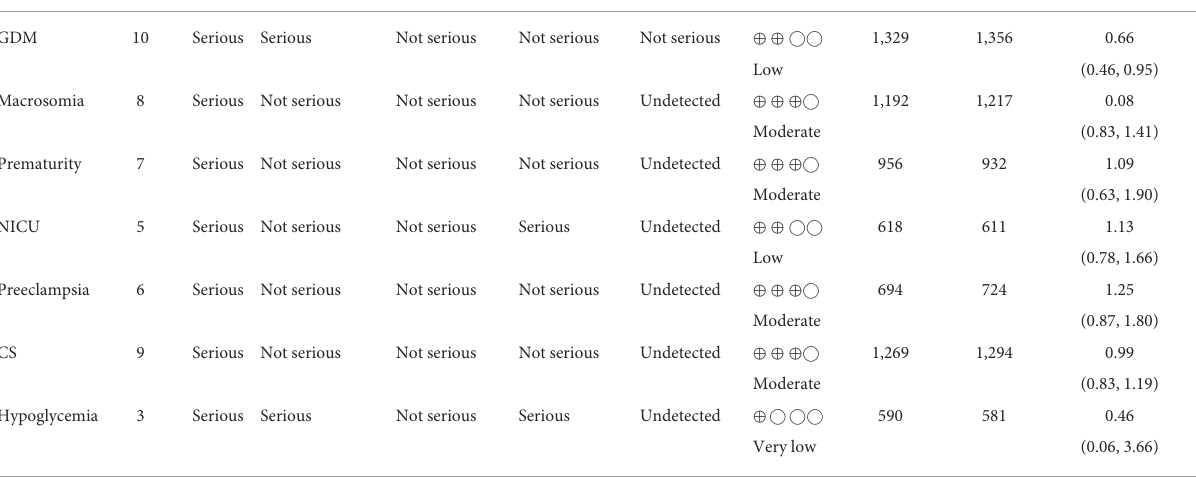
TABLE 3 Quality of evidence using GRADE